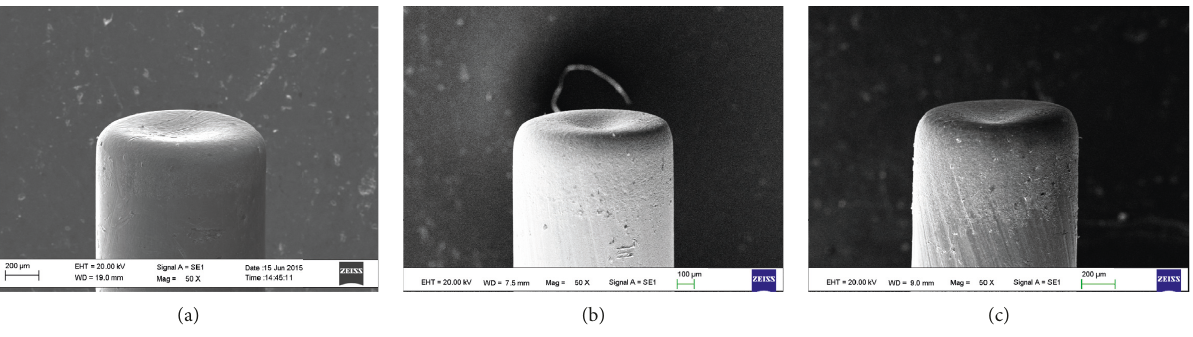
Figure 16: Shape change with flushing (no. 1 of Table 1). (a) s: 0r/min. (b) s: 10r/min. (c) s: